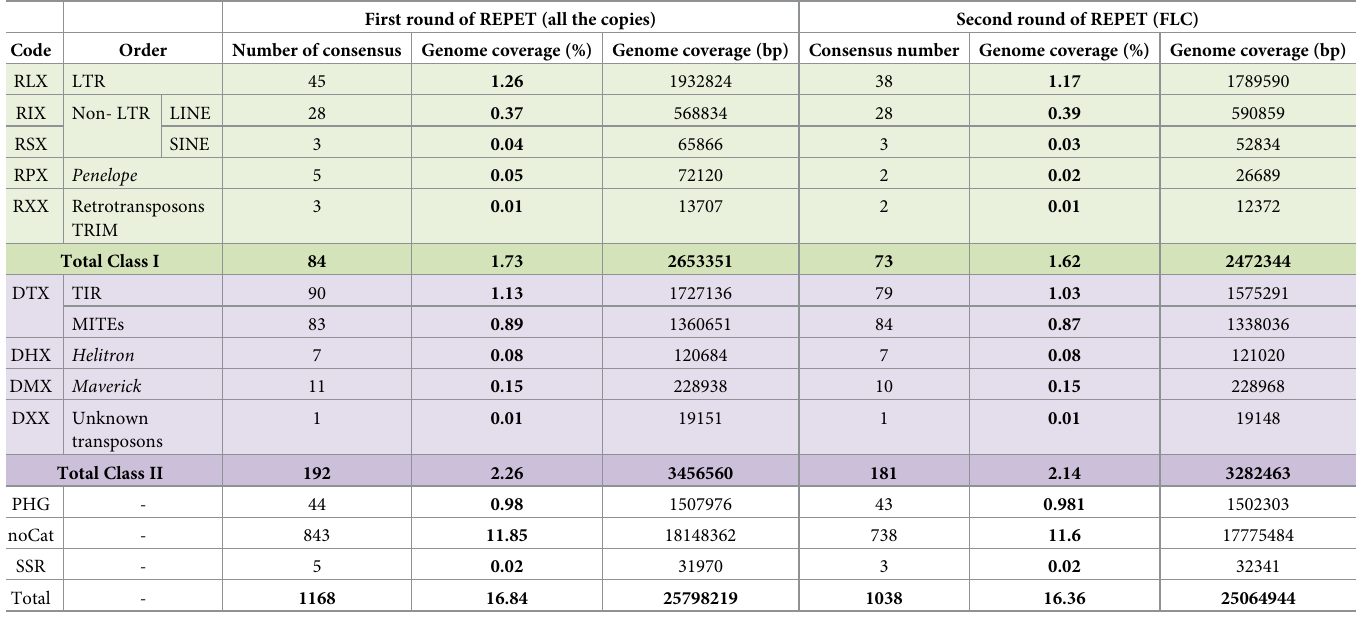
Table 1. Global statistics of TEs identified in the Mayetiola destructor genome. First round of REPET (all the